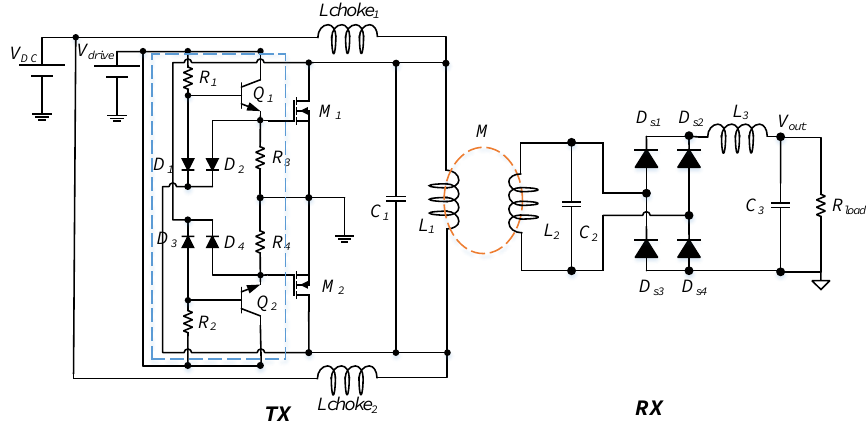
Figure 7. The schematic of an improved autonomous current-fed push-pull IPT system. Table 3. Parameters and components of the improved circuit.